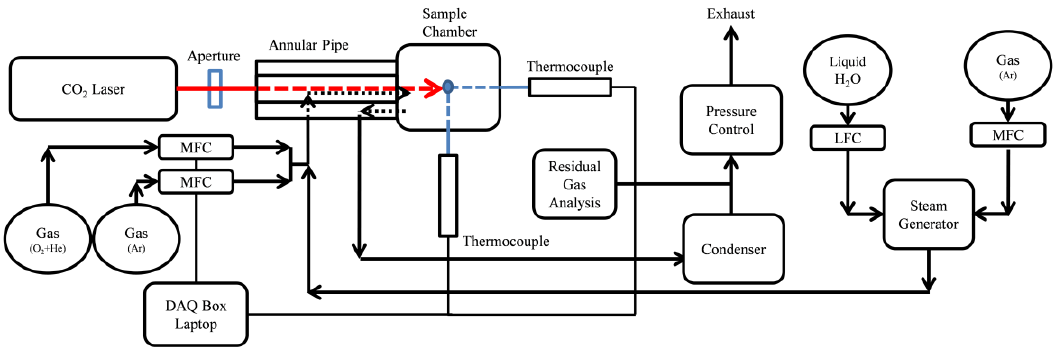
Figure 1. A schematic of a laser-based heating system coupled with a mass spectrometry.